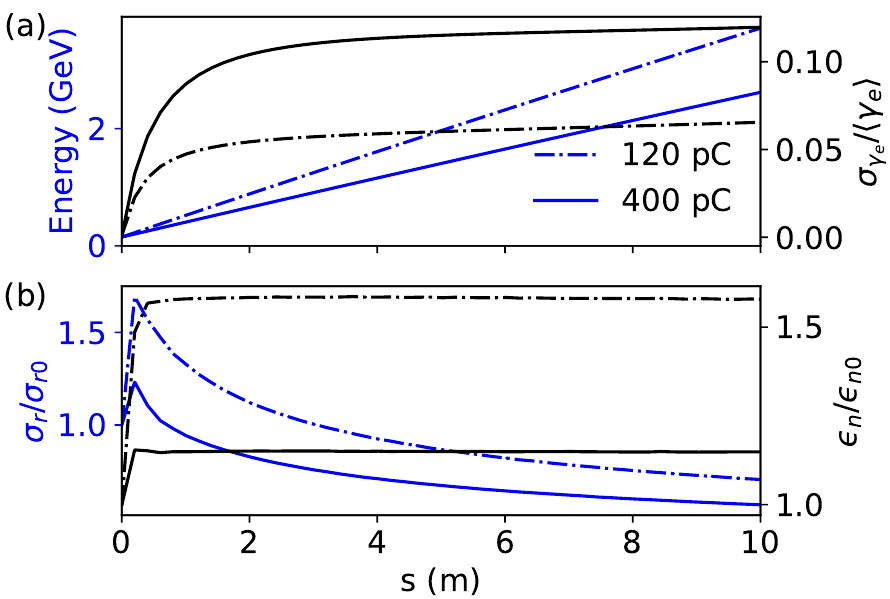
Figure 3. Evolution of the Gaussian witness beam characteristics as a function of the beam propa- gation distance s . ( a ) The average beam energy (blue lines) and the relative energy spread σ γ (black lines). (cid:104) γ e (cid:105) is average Lorentz gamma factor that represents the beam energy. ( b ) The RMS transverse size σ r (blue lines) and the normalized projected emittance (cid:101) n (black lines). Results of both the low-charge (120 pC, denoted by dash-dotted lines) and high-charge (400 pC, denoted by solid lines) cases are